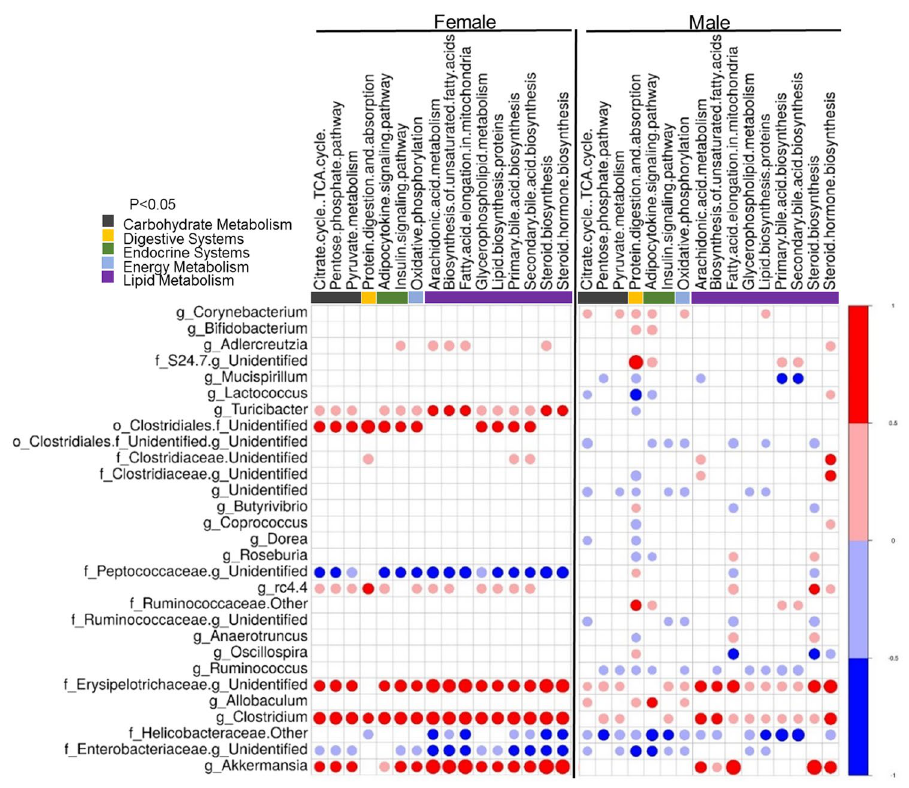
Figure 5. Maternal HFD and offspring sex significantly alter lipid metabolism and bile acid secretion synthesis pathways. Correlations between a PICRUSt-generated functional profiles and genus level bacterial abundance were calculated and plotted between HFD-fed male (M-HH) and female (F-HH) offspring from HFD-fed dams. Lipid metabolism and bile acid secretion synthesis pathways are indicated at the top of the graph. Left panel of the graph represents HH-female offspring while HH-male offspring are presented on the right panel. The shading intensity of the bubble, along with size, is indicative of the Kendall rank correlation coefficient between matrices. Red designates a positive association while blue designates a negative association. Only significant (p-value ≤ 0.05 by Kendall’s test; n = 5–7) correlations are visible in the